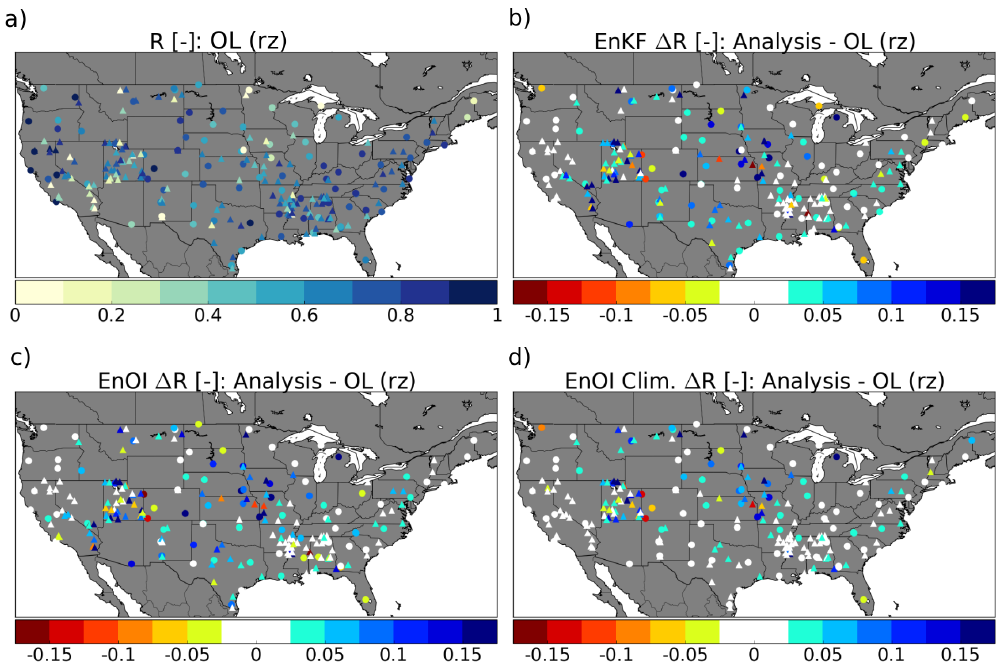
Figure 6. ( a ) Pearson R correlation coefficient between the ensemble open-loop (eOL) root-zone soil moisture and the SCAN (triangles) and USCRN (circles) stations. Yellow/blue indicate low/high correlation. ( b ) ∆ R (EnKF correlation minus eOL correlation), blue/red colours indicate positive/negative impact (153 of 223 stations improved). ( c ) ∆ R EnOI (135 of 223 stations improved), ( d ) ∆ R EnOI-Clim (145 of 223 stations